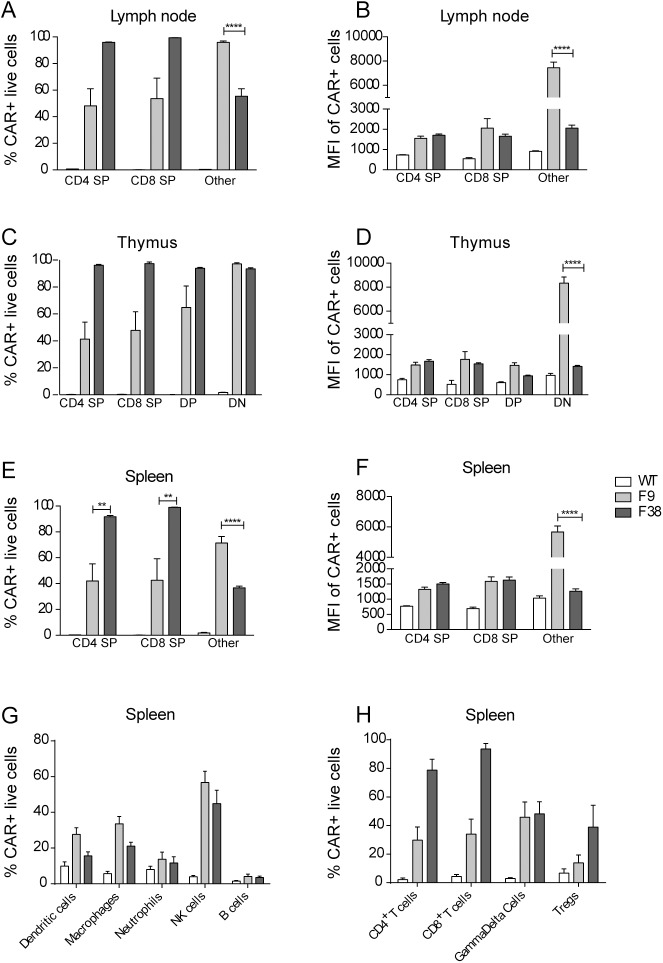
Multiple immune subsets express a CAR in the spleen, thymus and lymph node of vav-CAR mice.Splenocytes and lymphocytes derived from the thymus and lymph nodes of vav-CAR and WT mice were stained for surface markers (markers from Fig 4) and chimeric antigen receptor expression. (A, C, E, G, H) Specific immune subsets were gated on to determine the percentage of CAR positive cells and (B, D, F) the mean fluorescence intensity (MFI) of CAR expression. Data represents the mean ± SEM of (WT = 4, F9 and F38 = 4–8) mice. **p<0.007, ****p<0.0001. SP: Single positive, DP: Double positive, DN: Double negative, Other: Negative for CD4, CD8, CD3 and TCRβ.